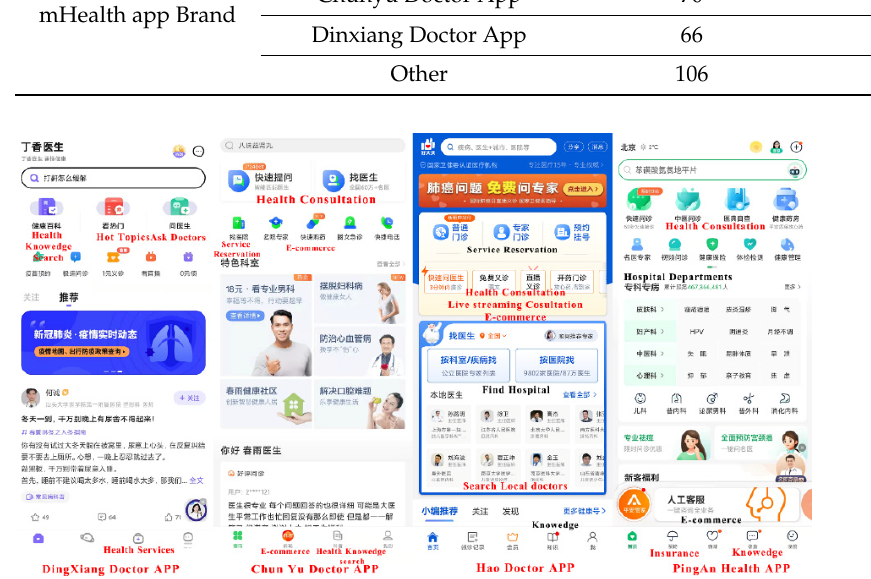
Figure 3. The main functions of respondents’ commonly used mhealth apps. To avoid a nonresponse bias, a paired samples t -test was conducted for the top 20 and Table 1. Demographic details of the survey respondents. bottom 20 respondents who submitted the questionnaire. The results showed no significant differences between the two